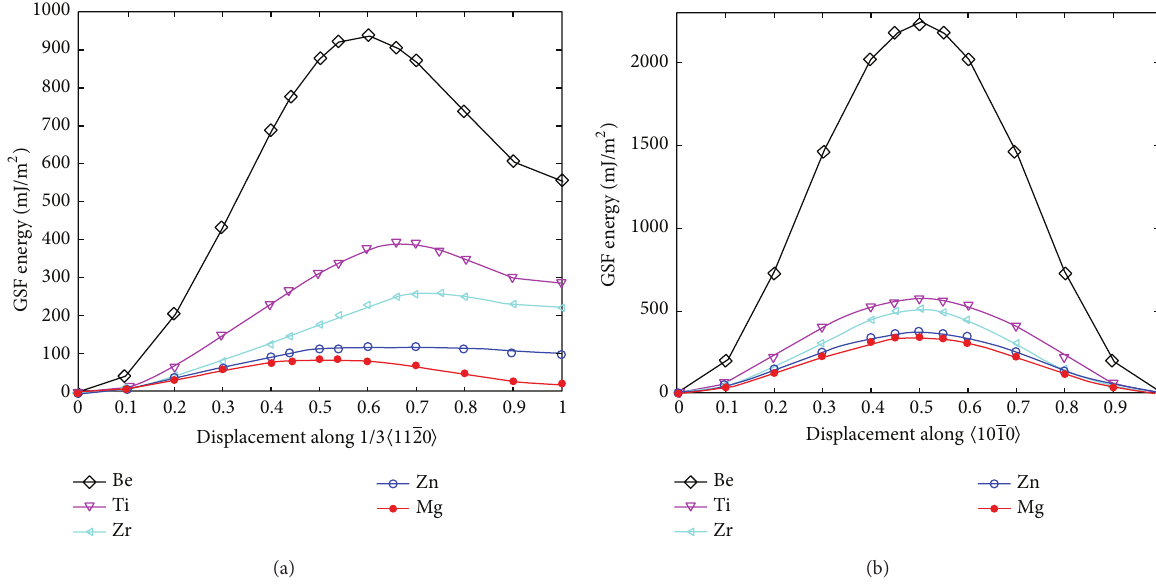
Figure 1: The GSF energy for the basal plane along ⟨1120⟩ and ⟨1010⟩ directions. The figure is adapted from [24].